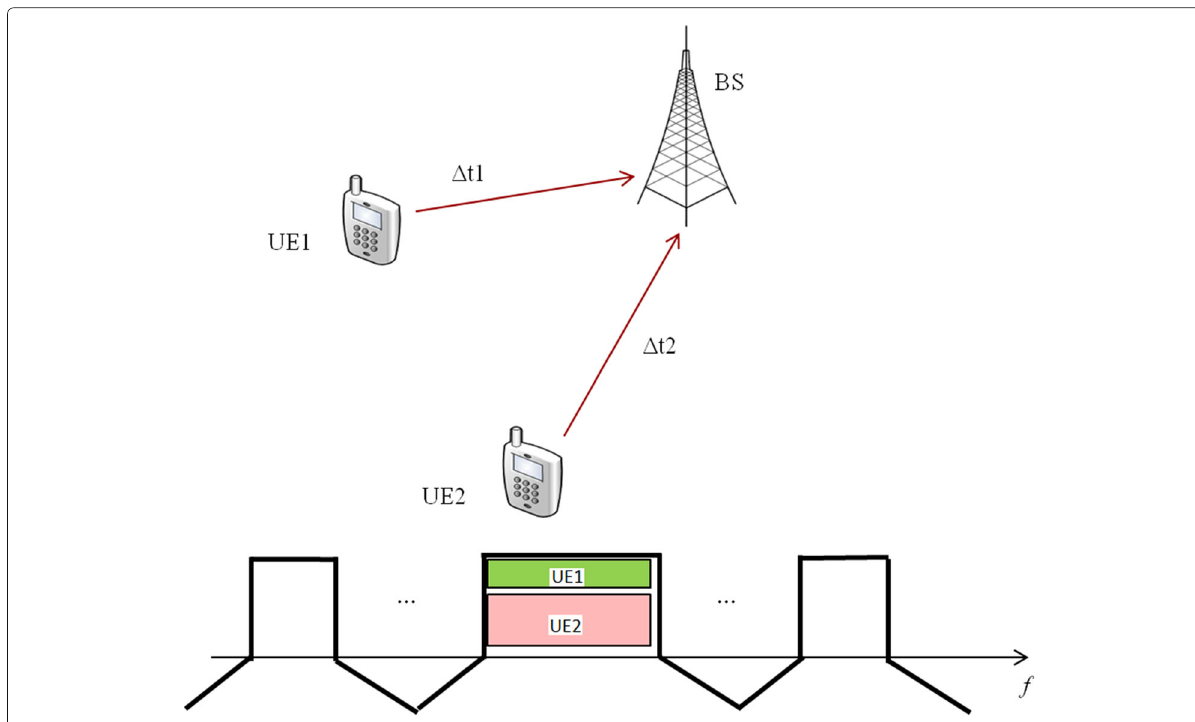
Fig. 17 Scenario for uplink massive access without